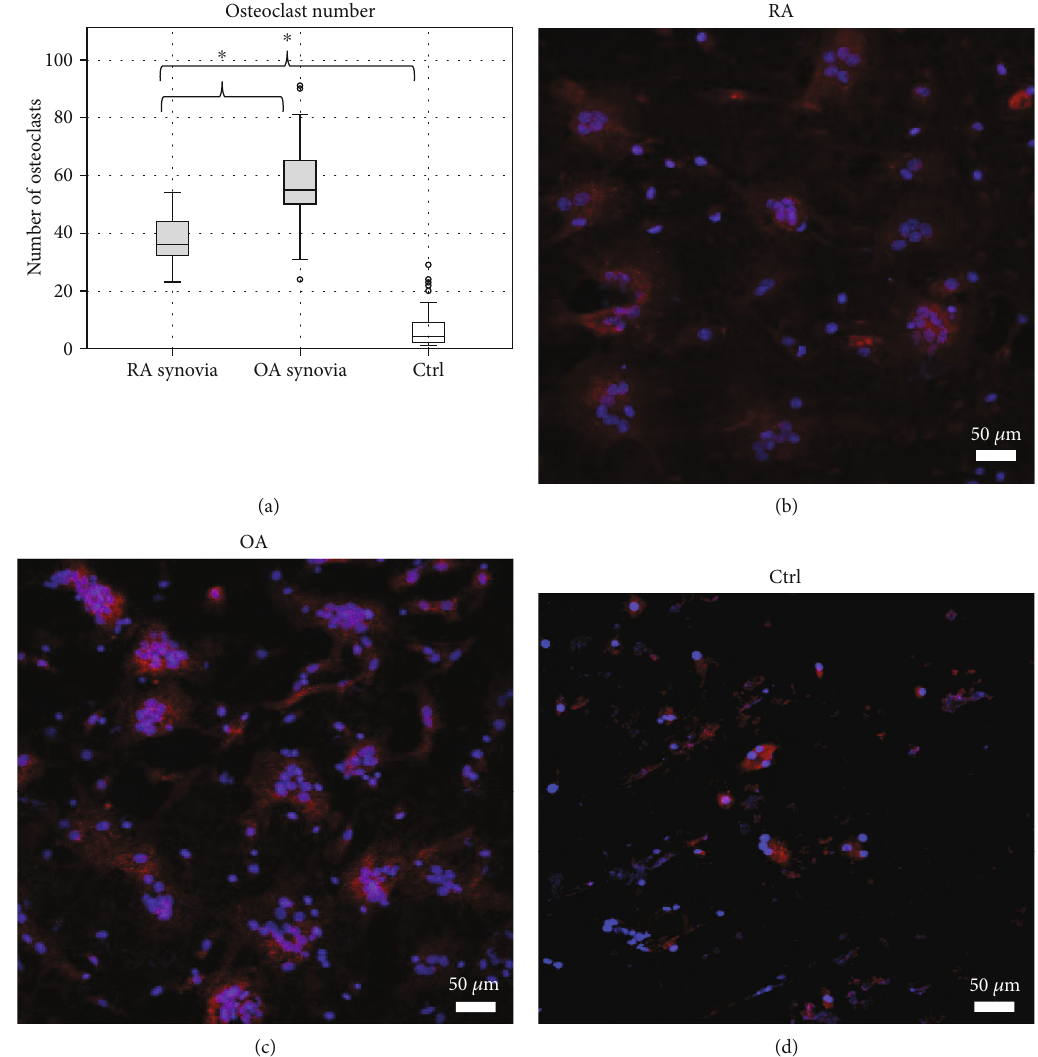
Figure 4: Osteoclast numbers in cultures with RA and OA synovial fl uid. Panel (a) shows the mean osteoclast count in cultures with synovial fl uid from RA ( n = 13 ) and OA ( n = 12 ) patients with healthy control serums as control. Both RA and OA synovial fl uids increased the number of osteoclasts when compared to healthy serum. Surprisingly, OA synovial fl uid increased the number of osteoclasts signi fi cantly more than RA synovial fl uid. A di ff erence in osteoclast phenotype was seen between cultures with RA (b) and OA (c) synovial fl uids. 10x magni fi cation confocal microscope images. The cells cultured with OA synovial fl uid, which contained less in fl ammatory cytokines, were larger and contained more nuclei ( p < 0 : 05 ) than the osteoclasts cultures with RA synovial fl uid that contained higher concentrations of in fl ammatory cytokines. The osteoclasts cultured with healthy control serum (d) were even smaller and with fewer nuclei than in either culture with synovial fl uid. Red color indicates TRAcP and blue Hoechst stain marks the nuclei. Changes in cell morphology are described in detail in Table